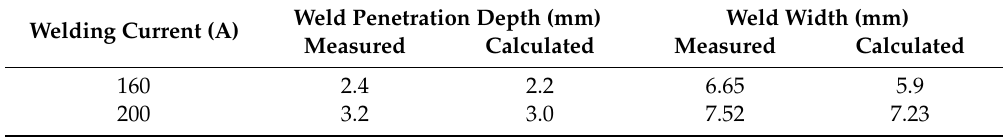
Table 3. Comparison of the predicted and measured weld cross section